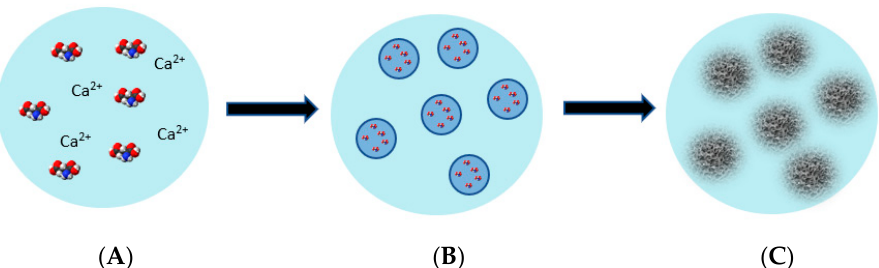
Figure 9. Proposed mechanism: ( A ) = L-glu and the inorganic additive are dissolved in water, ( B ) = a quasi-emulsion of drops of water of L-glu and the inorganic additives in ethanol, ( C ) = crystallization of L-glu inside the emulsion droplets.